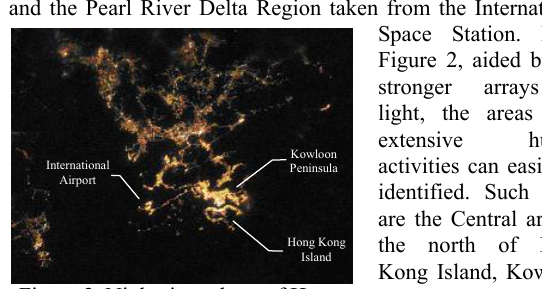
Figure 2, aided by the stronger arrays of light, the areas with